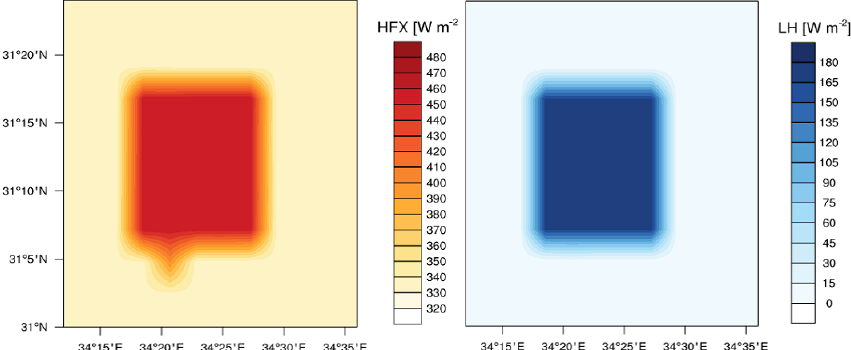
Figure 12. Mean daily maximum of sensible and latent heat flux (JJA) in WRF Impact to show the spatial gradient between the plantation and the surrounding desert. Values of HFX over plantation and desert are around 460 and 330 Wm -2 respectively (a 130 Wm -2 gradient). Values of LH over plantation and desert are around 165 and 0 Wm -2 respectively (165 Wm -2 gradient). 80 W m − 2 fluctuation it is likely then that ET 0 variability is driven predominantly by that of R n